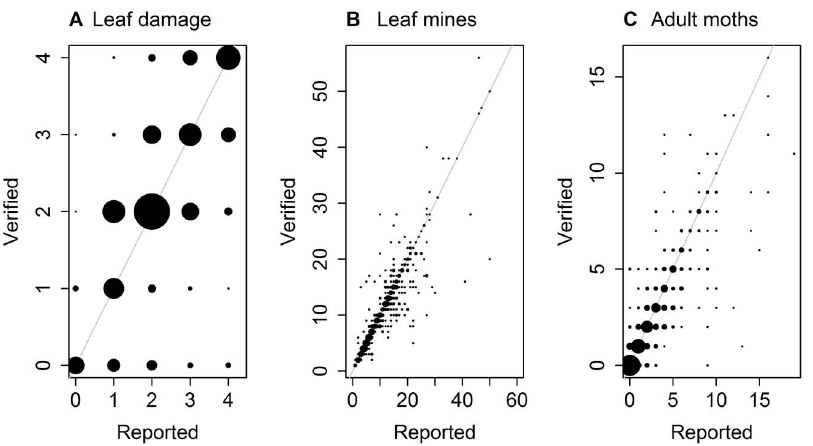
Figure 3. Accuracy of reported counts of (A) leaf damage, (B) leaf mines and (C) adult moths. The area of the circles is proportional to the frequency of reports. The maximum circle size represents 1233, 20 and 178 records for A, B and C, respectively. The 1:1 line is shown in grey.